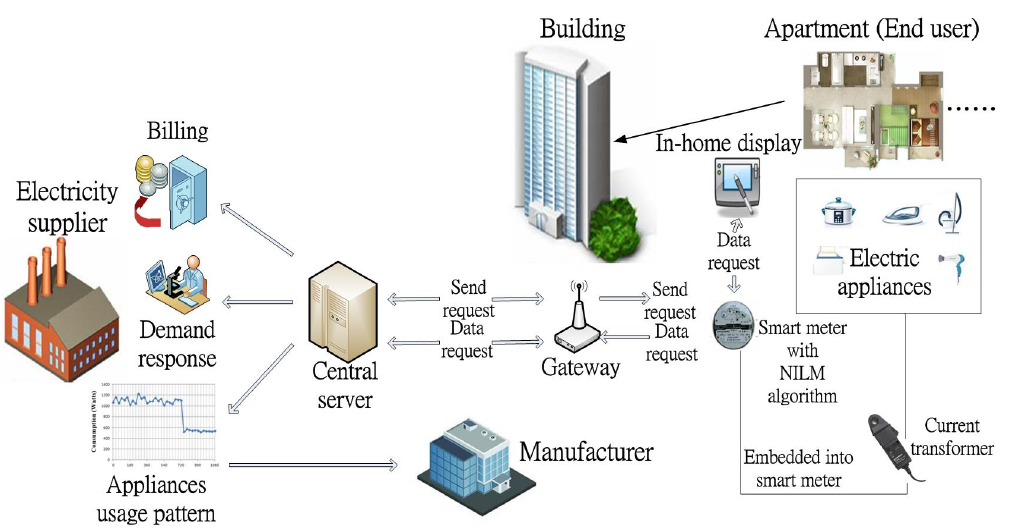
Figure 1. Non-intrusive load monitoring (NILM)—general architecture: Electricity suppliers, companies and end